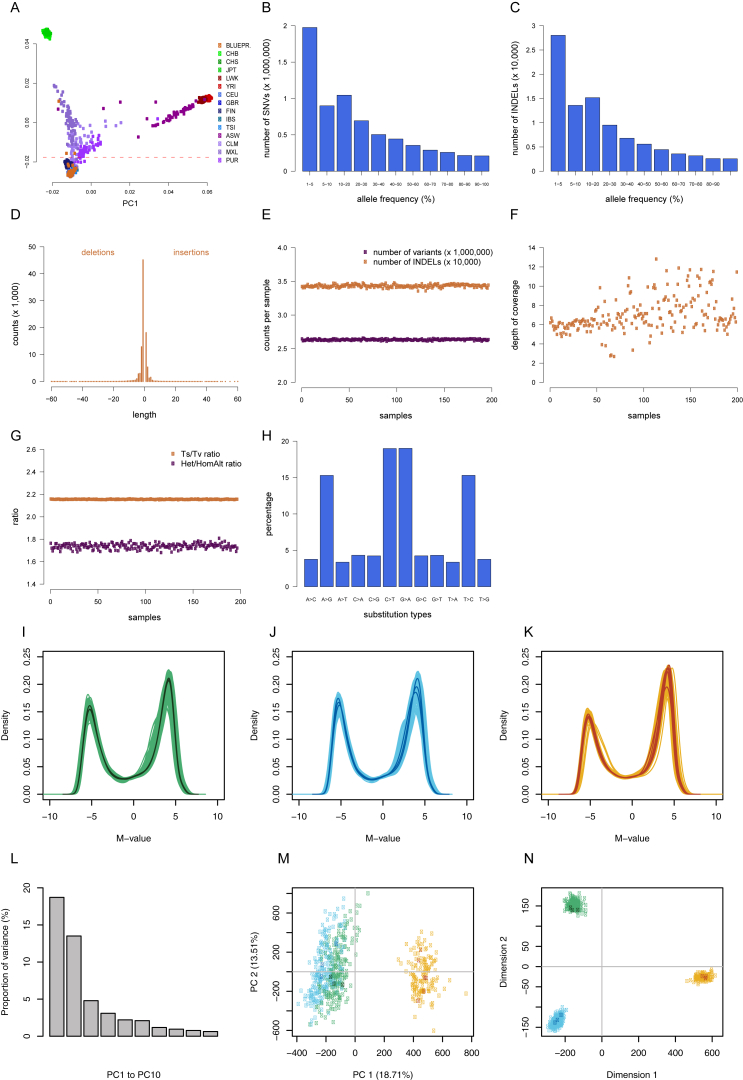
WGS and DNA Methylation Sample and Data Quality Metrics, Related to Figures 3 and 4WGS (A-H) and DNA methylation (I-N) sample and data quality metrics. (A) Principal component analysis (PCA) scatterplot of the first two components using the resulting merged datasets (1000GP + Blueprint). The dashed line indicates the arbitrary threshold to discriminate the population of European ancestry. (B) Number of SNPs (x106) by non-reference allele frequency (AF) bins. (C) Number of INDELs (x104) by non-reference AF bins. (D) Size distribution of INDELs. Negative lengths represent deletions and positive lengths represent insertions. (E) Number of SNPs (x106) and INDELs (x104) by sample. (F) Depth of coverage by sample. (G) Ratio of heterozygous and homozygous non-reference SNP genotypes by sample and transition to transversion ratio (Ts/Tv) by sample. (H) Types of substitution in percentage. (I-K) Distributions of DNA methylation M-values for each cell type. Each line represents one sample. (L) Barplot representing the proportions of variance explained by the first ten principal components of a principal component analysis across all samples used in the study. (M) Visualization of the first two principal components of a principal component analysis across all samples used in the study. Each data point represents one sample, colored by cell type. (N) Multidimensional scaling of all samples used in the study, based on Euclidean distances. Each data point represents one sample, colored by cell type.